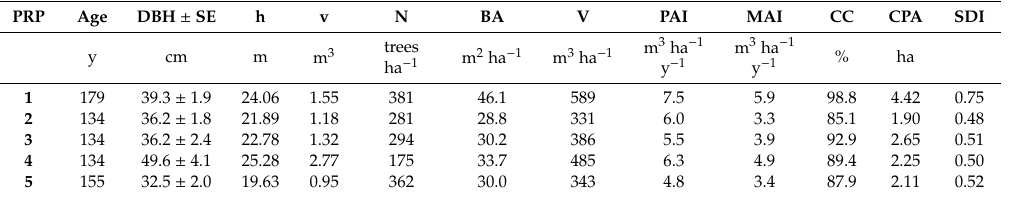
Table 3. Structural characteristics of forest stands on permanent research plots in 2016.